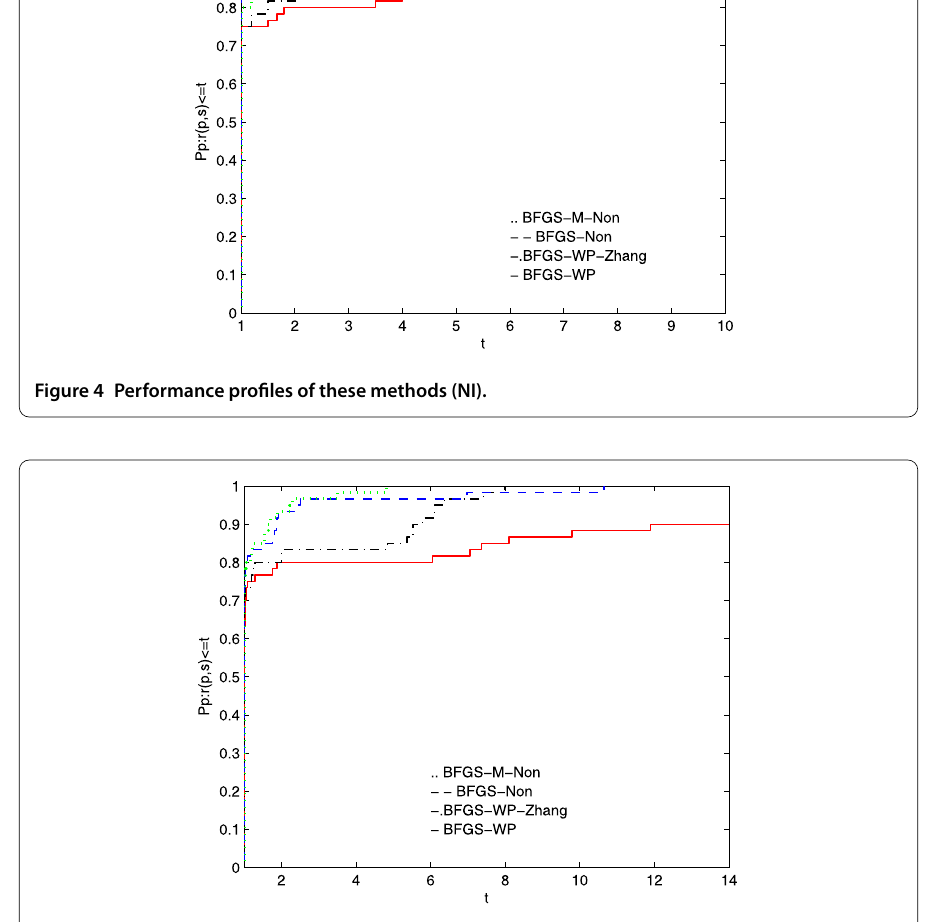
Figure 5 Performance profiles of these methods